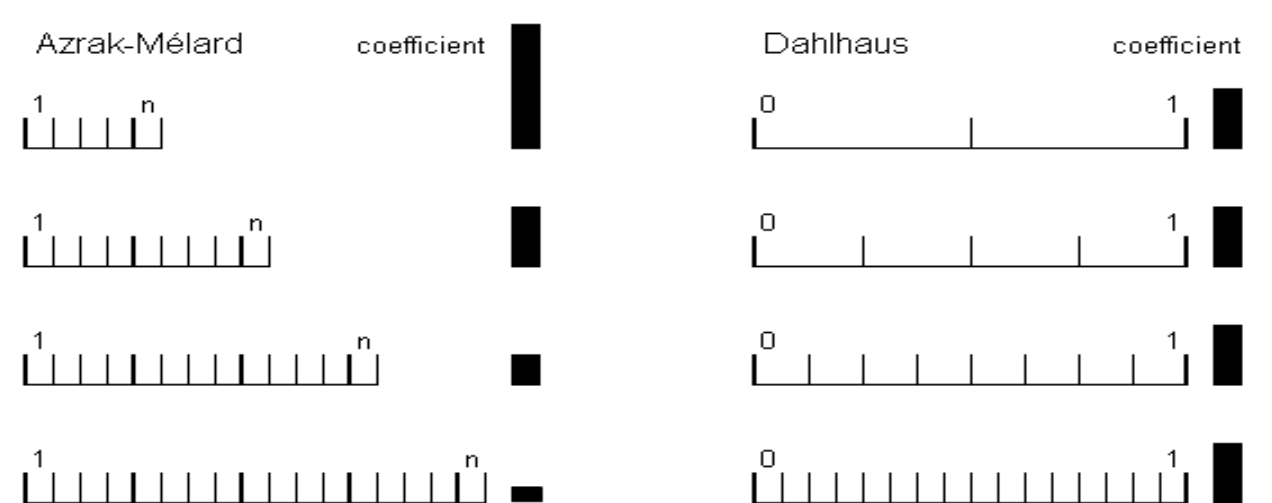
Figure 1. Schematic presentation on how to interpret asymptotics in AM and LSP theories (see the text for details).